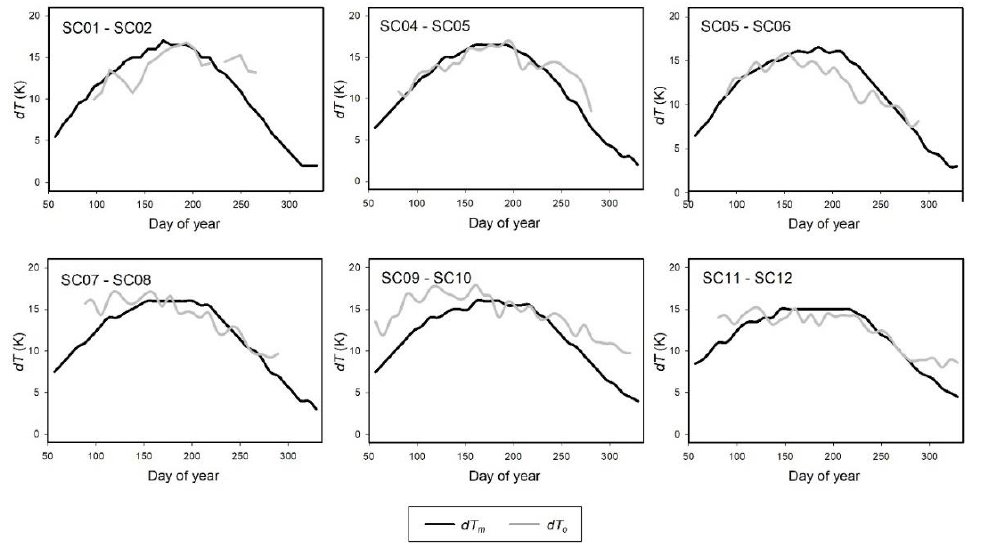
Figure 5. Timeseries plots of dT o and dT m for the sample blocks in the South-Central region. The labels in each plot indicates the paired sampling blocks shown in Figure 3.